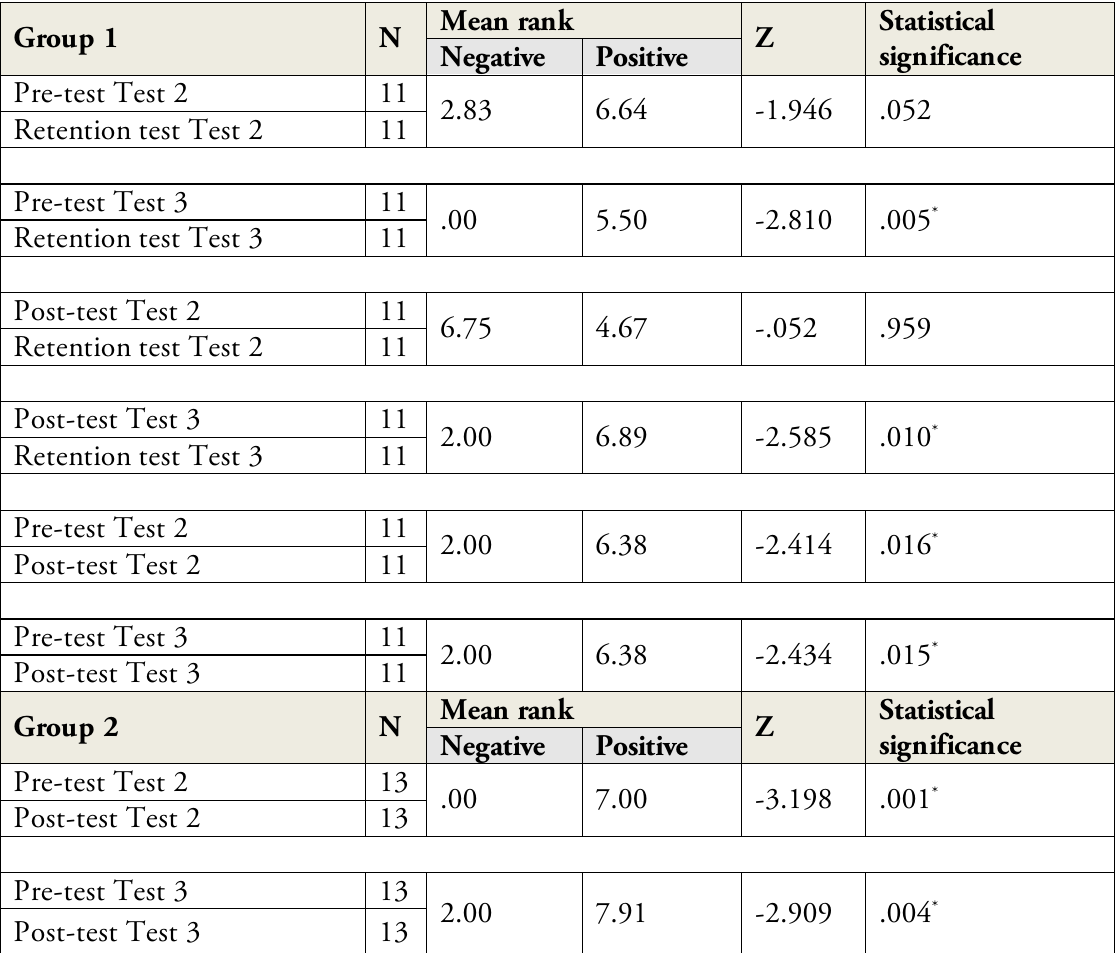
Table 3: Significance of differences between pre- and post-test means within groups as measured by the Wilcoxon Signed ranks test Statistical significance: * p <